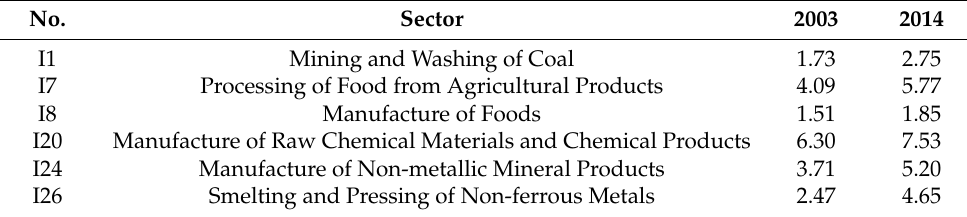
Table 5. The increase in the share of the output of I1, I7, I8, I20, I24 and I26 from 2003 to 2014 (%).